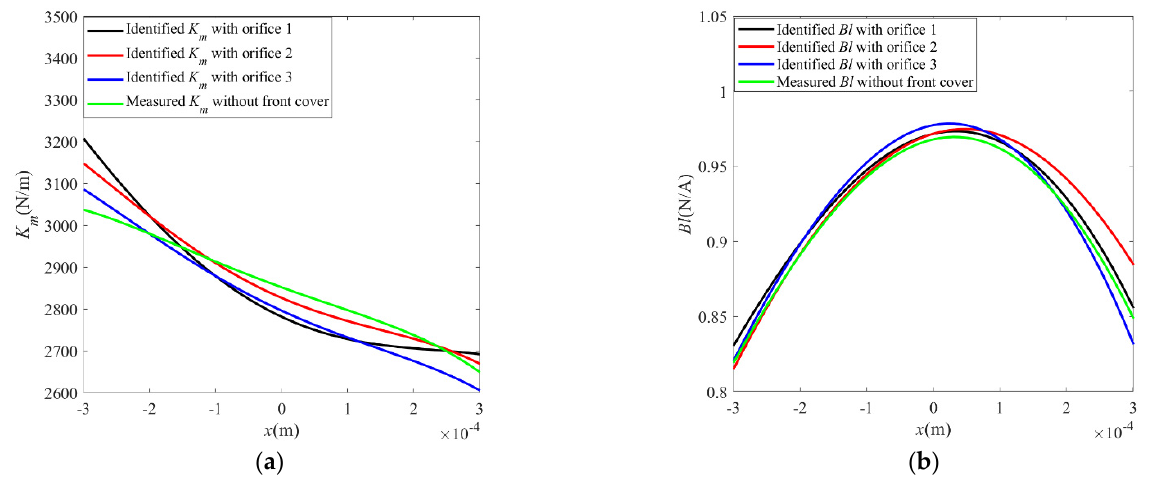
Figure 8. Comparison of the ( a ) nonlinear stiffness K m ( x ) and ( b ) nonlinear force factor Bl ( x ).